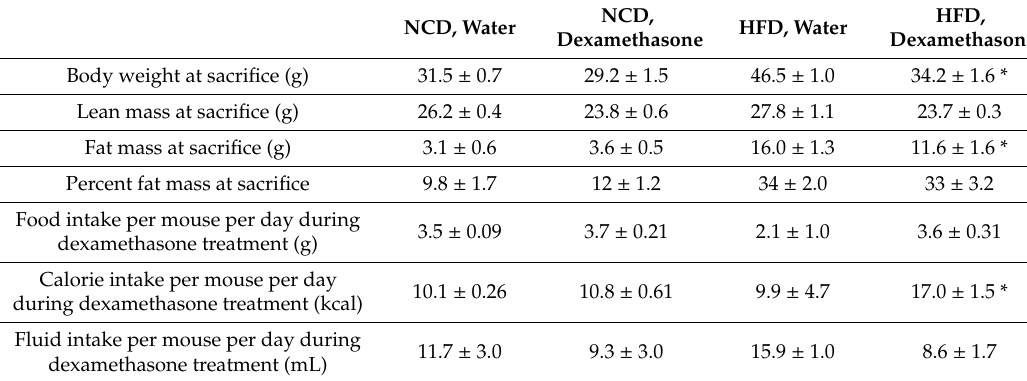
Table 1. Body mass, fat mass, calorie and dexamethasone intake. Asterisks indicate significant interaction between diet and dexamethasone treatment by two-way ANOVA. n = 6–8 mice per group. NCD, HFD, NCD, Water Dexamethasone